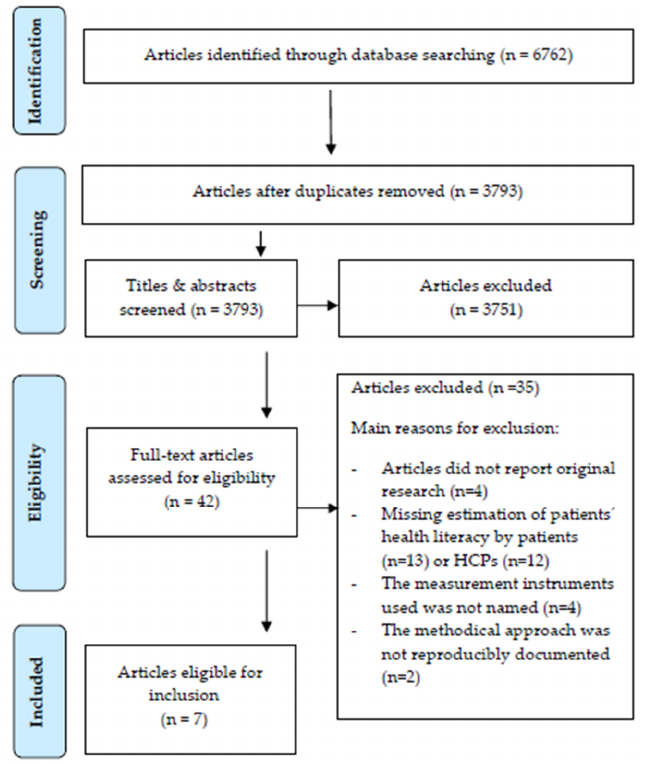
Figure 1. PRISMA flow